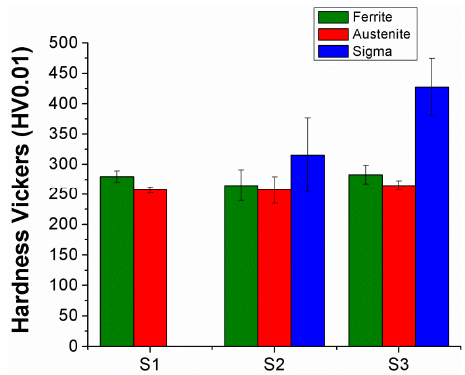
Figure 5. Microhardness Vickers values in ferrite, austenite and sigma phases for all samples of study.